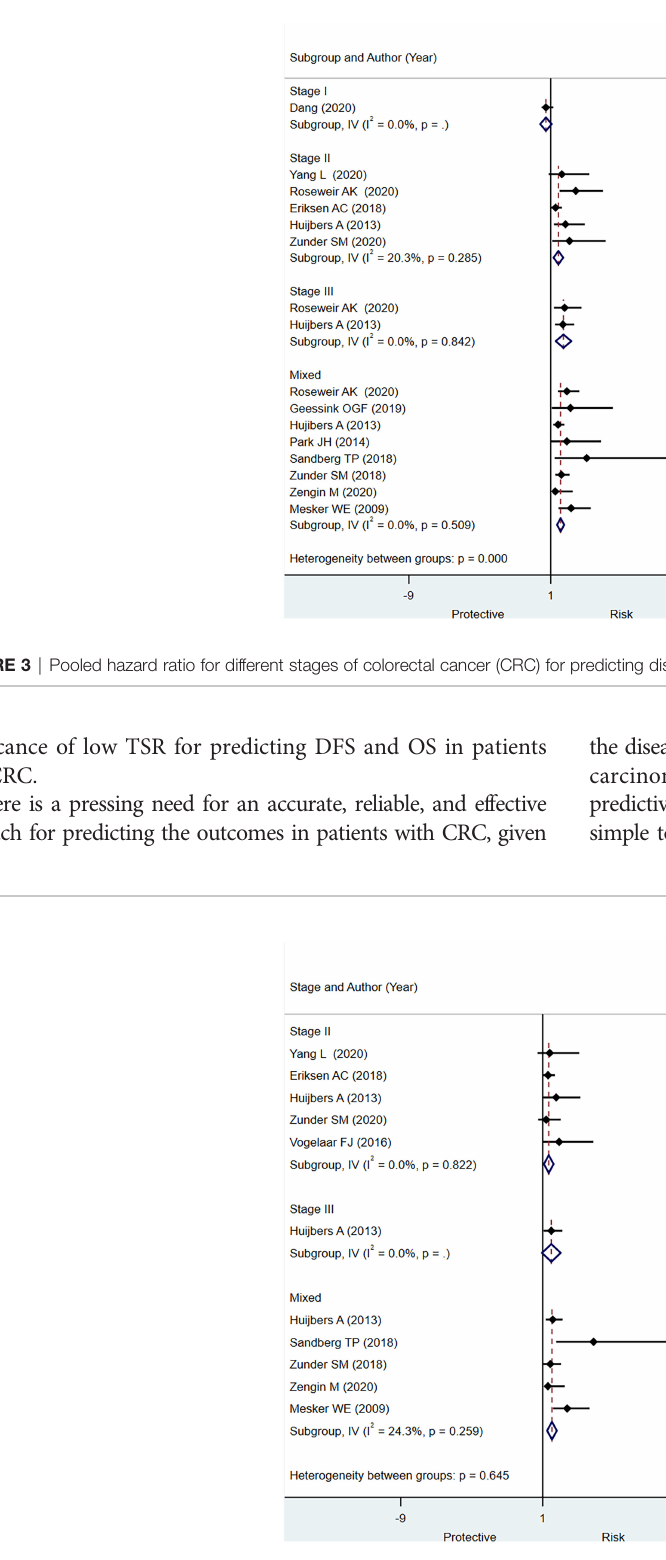
FIGURE 4 | Pooled hazard ratio for different stages of colorectal cancer (CRC) for predicting overall